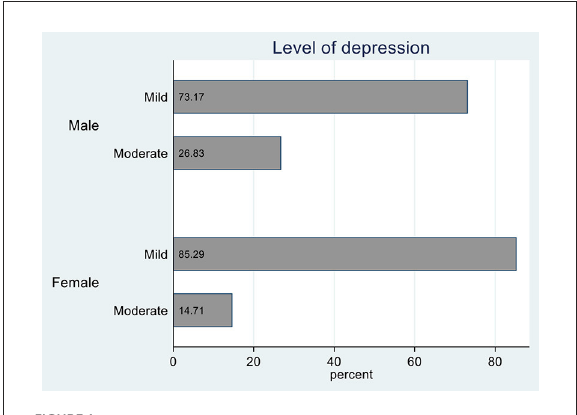
FIGURE1 Depression levels segregated by gender.